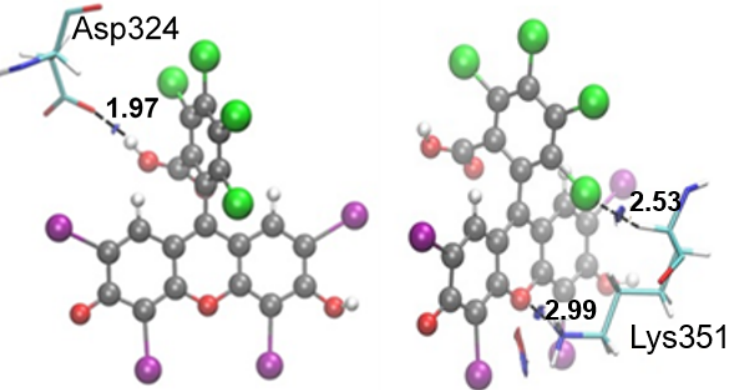
Figure 8. Interactions of RB dye to FA6 of HSA obtained in NCIplot studies and analyzed by VMD software.